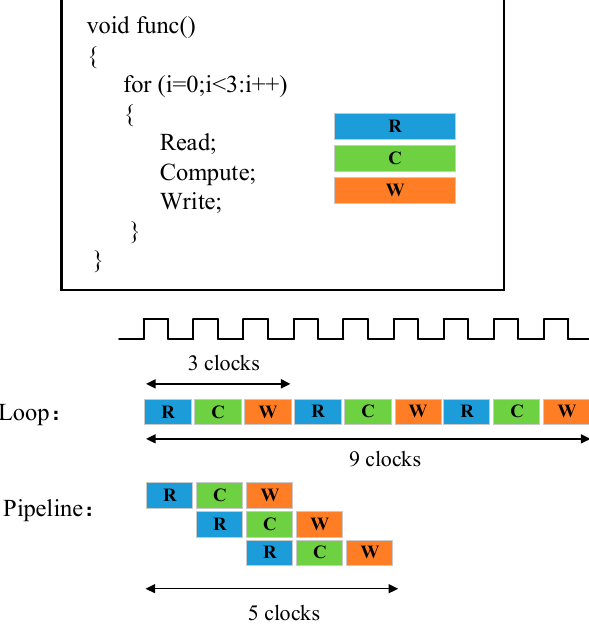
Figure 3. Pipeline instruction optimization